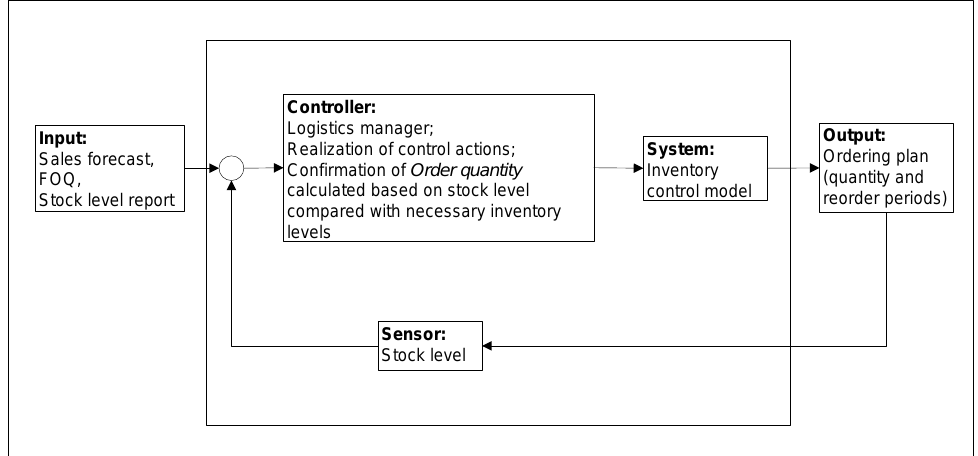
Figure 2. Elements of the feedback loop for the inventory control model.